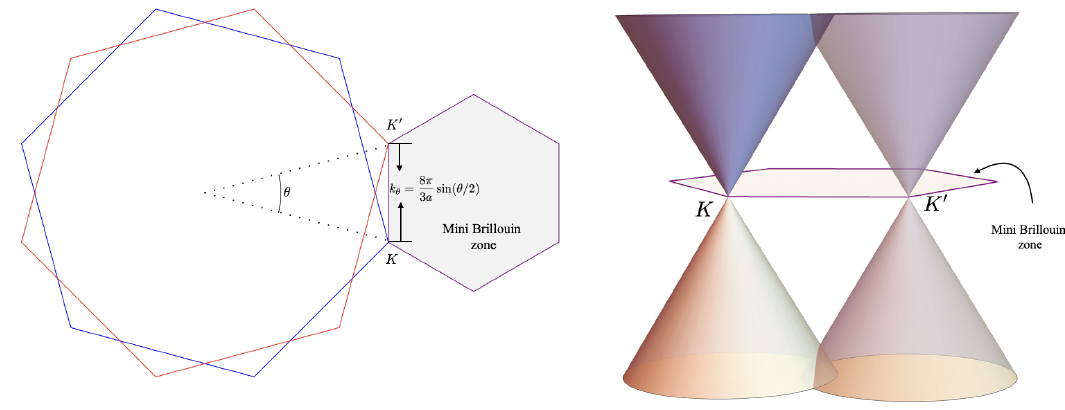
Figure 5 . Couple of Dirac points depicting the dispersion relation in Moire Brillouin zone (mo- mentum space), in absence of inter-layer coupling. The separation between the Dirac points sin( θ/ 2) is twist angle dependent. Here a is the lattice parameter. The fermi velocity k θ = 8 π 3 a is, as expected, same as that of